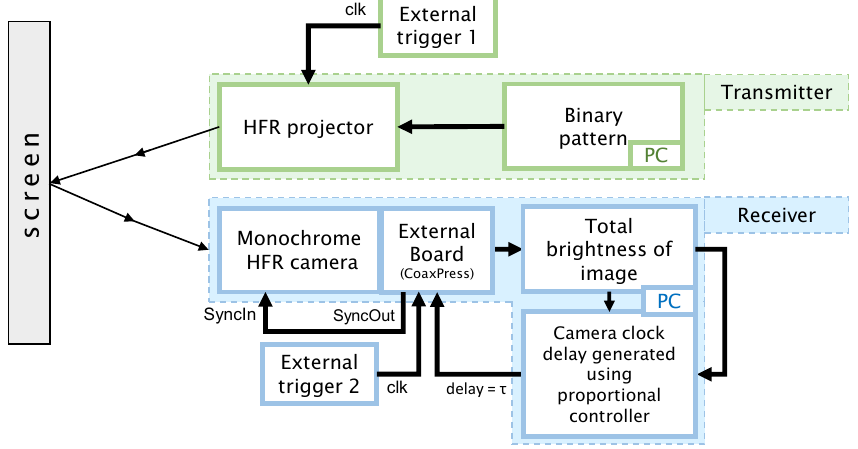
Figure 2. Concept diagram of visual-feedback-based HFR projector–camera